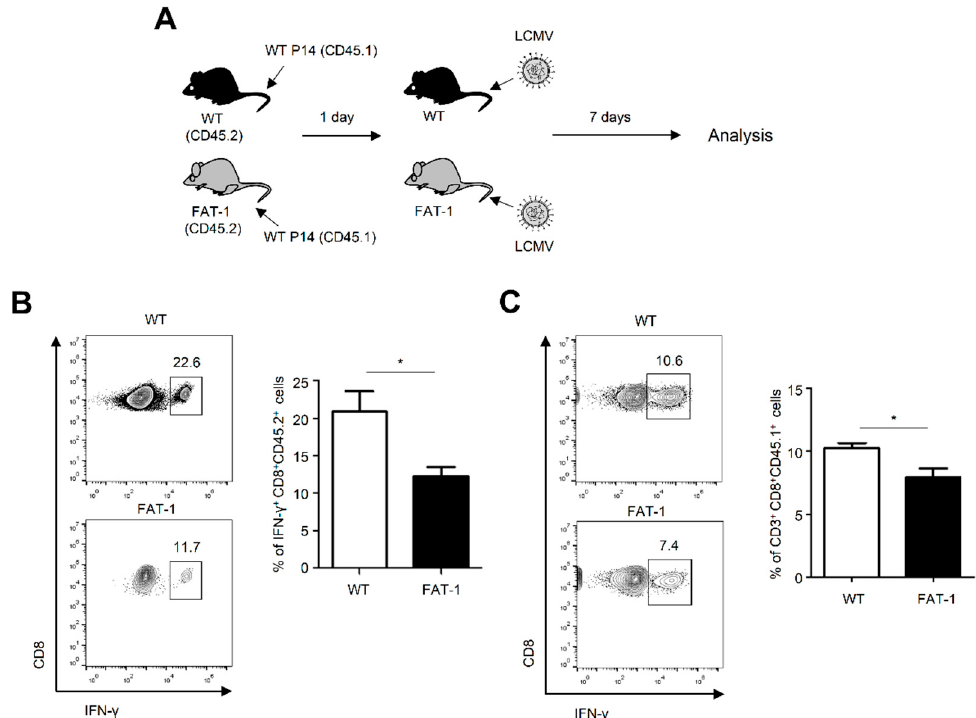
Figure 4. Wild type anti-viral CD8 + T cell responses were suppressed in FAT-1 mice. ( A ) P14 cells were adoptively transferred into WT and FAT-1 mice 1 day before infection with LCMV (Armstrong) for 7 days. ( B , C ) Splenocytes were stimulated with LCMV GP33 peptide for 5 h and intracellular staining occurred for IFN- γ . The representative flow cytometry plots for the expression of IFN- γ in CD45.2 + CD8 + cells ( B ) or CD45.1 + CD8 + cells ( C ) were shown (left panels). The graph shows the percentage of IFN- γ -producing cells (right panels). The data represent the mean ± SEM ( n = 3 mice per group). * p ≤ 0.05. The data represent the results of at least three independent experiments.